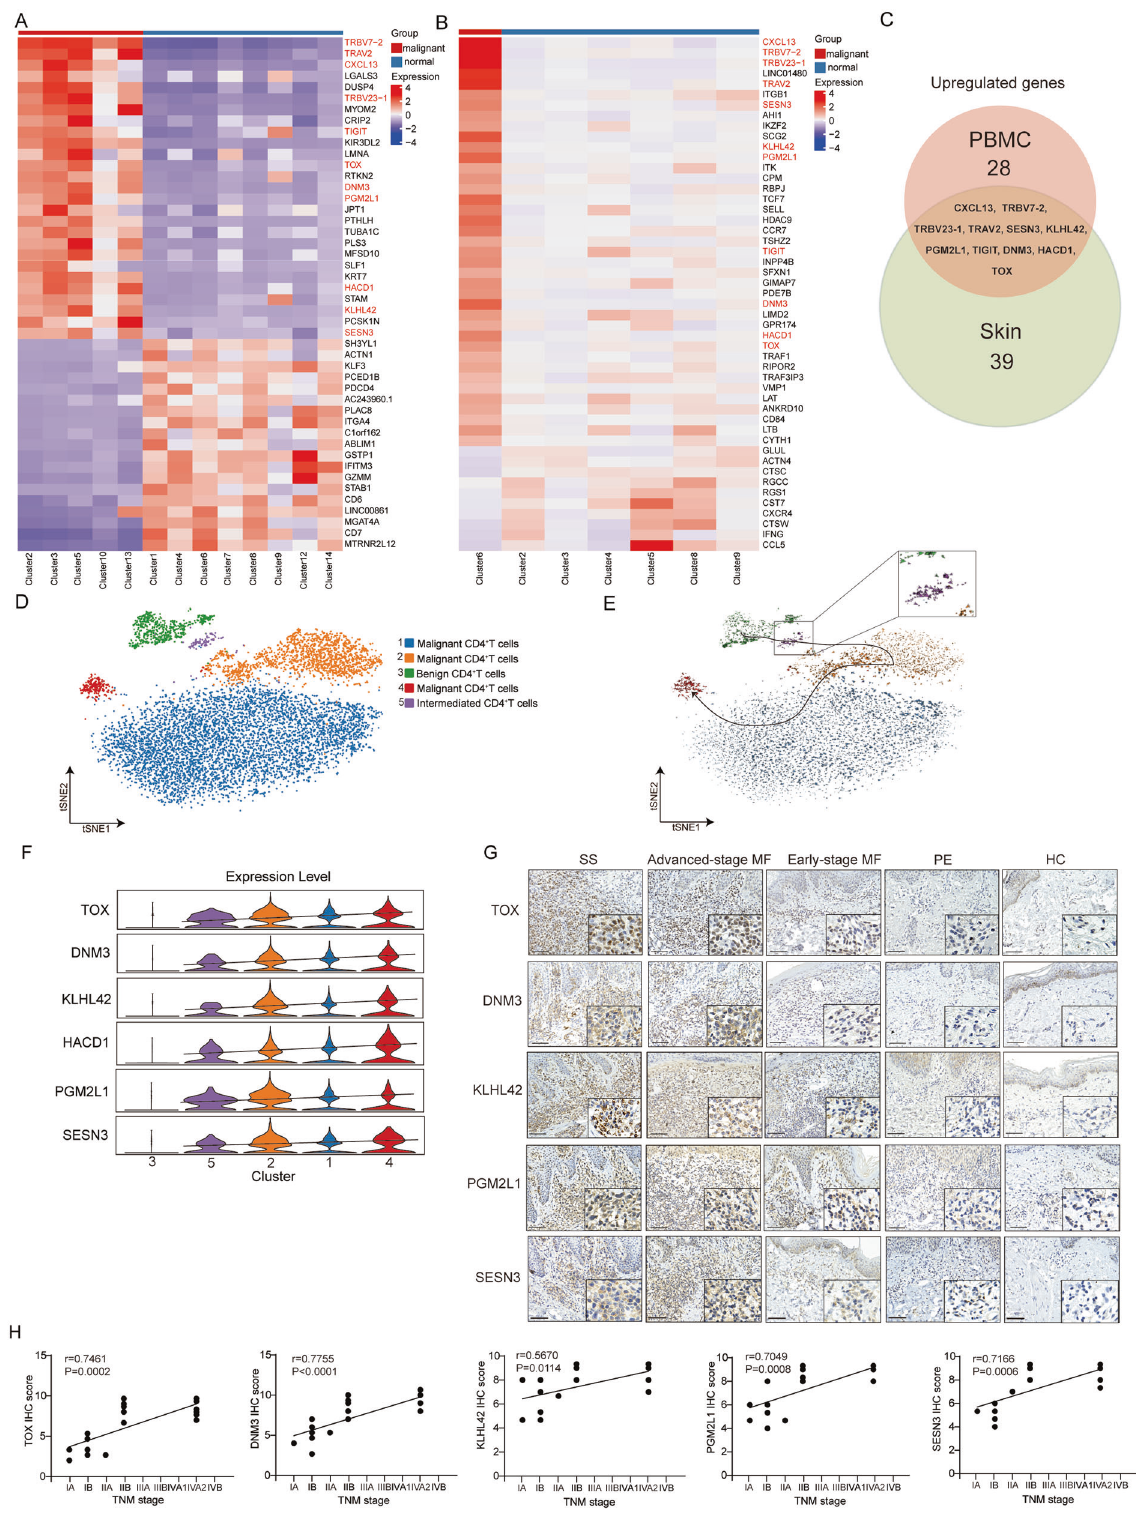
Fig. 4 Identi fi cation of speci fi c marker genes correlated with MF/SS disease progression. A Heatmap of signi fi cantly DEGs in each subset of malignant and benign CD4 + T cells from PBMCs. B Heatmap of signi fi cantly DEGs in each subset of malignant and benign lymphocytes from skin tissues. C Venn diagram showing overlap of signi fi cantly upregulated expressed genes of blood- and skin-derived malignant CD4 + T cells. D t-SNE visualization of scRNA-seq data from PBMC CD4 + T cells in the SS patient. E RNA velocity analysis of PBMC CD4 + T cells in the SS patient. F Violin plots showed the expression of TOX , DNM3 , KLHL42 , HACD1 , PGM2L1 , and SESN3 in each cluster. G Immunohistochemical stain of TOX , DNM3 , KLHL42 , PGM2L1 , and SESN3 in skin biopsies of HC, PE patient, early-stage MF patients, advanced-stage MF patients and SS patients, each at 200× (left) and 400× (right). H Correlation analysis of disease stage with IHC scores of TOX , DNM3 , KLHL42 , PGM2L1 , and SESN3 in MF/SS. Pearson ’ s correlation coef fi cient. Cell Death and Disease (2022)